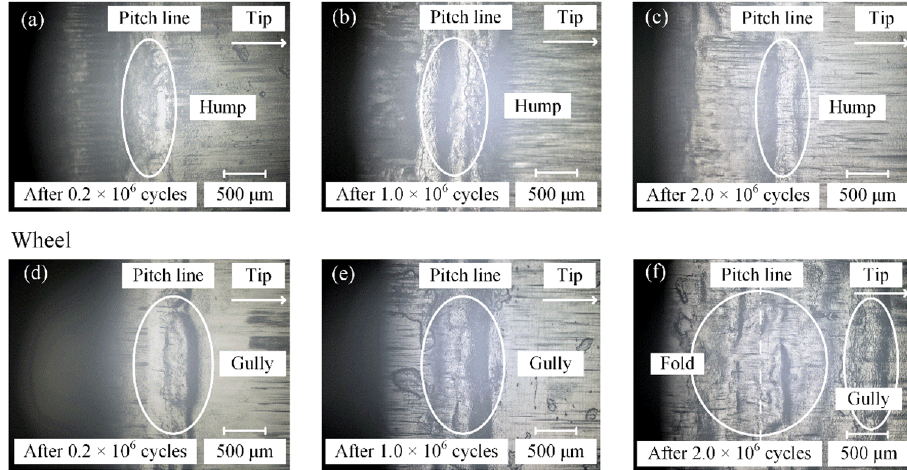
Fig. 9 Wear evolution for the 13 N·m load under the dry running condition.